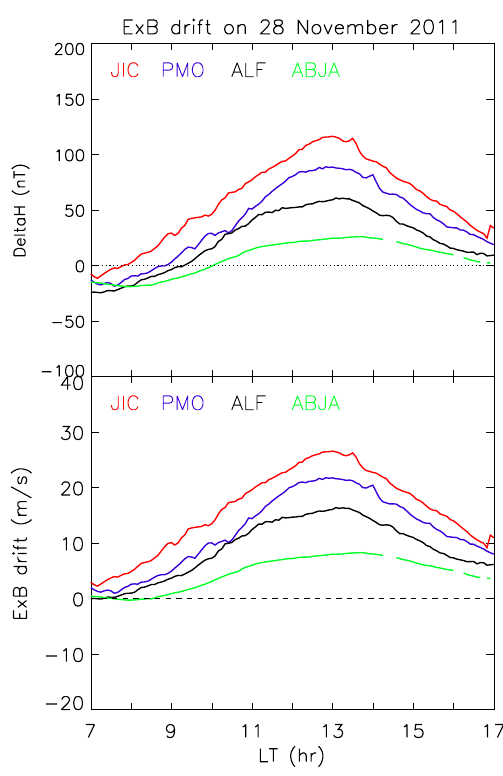
Fig. 3. The difference between magnetic fluctuation recorded at the geomagnetic equator and off the equator (top panels), and an esti- mated E × B drift (bottom panel). Different colors both in the bot- tom and top panels represent different longitudinal